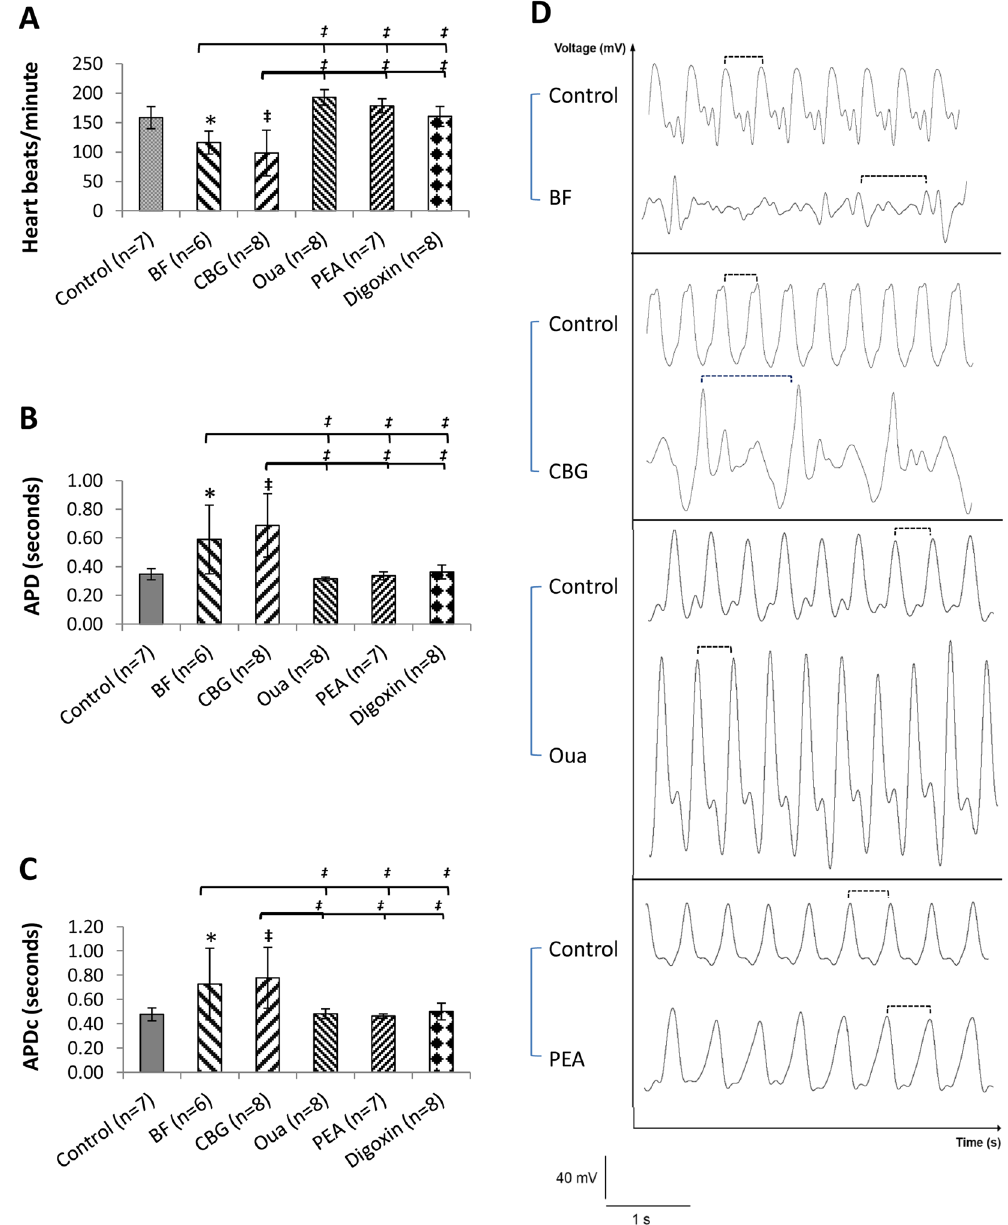
Figure 7. Effect of CGs on the APs of Zebrafish larva. Effects of BF, CBG, Oua and PEA (all at 100 µ M) on the APs, controlled by digoxin, were analysed in day-3 Zebrafish larva. ( A , B and C ) Bar-graphs show the effects of various CGs on heart rates, APD and APDc, respectively. ( D ) Representative waveforms of APs recorded. The dashed lines indicate the representative APDs. * p < 0.05, ‡ p < 0.001, vs. control; ‡ p < 0.001, vs. BF or CBG (One- Way ANOVA). Data are presented as mean ±